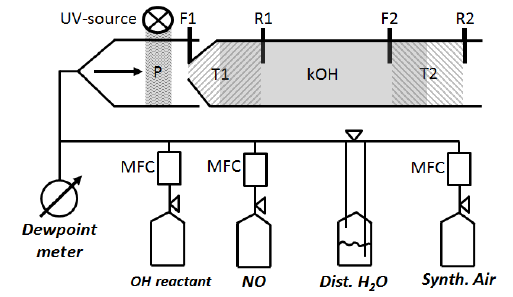
Figure 2. Schematic of CIMS flow tube with two titration zones: P represents OH and HO 2 production from H 2 O photolysis. T1 zone (left hatch) is the first titration zone (F1 up to R1) with H 2 SO 4 from OH titration by SO 2 injection at F1. T2 zone (right hatch) is the second titration zone (F2 up to R2) with H 2 SO 4 from OH titration by SO 2 injection at F2. R1 and R2 is where propane is added to stop H 2 SO 4 production from recycled OH after the first and second titration zone, respectively. k OH (grey solid) is total OH reactivity using ln ([OH] T1 / [ OH ] T2 ) indicating [OH] T1,T2 is reached after front (F1, F2) and before rear (R1, R2)